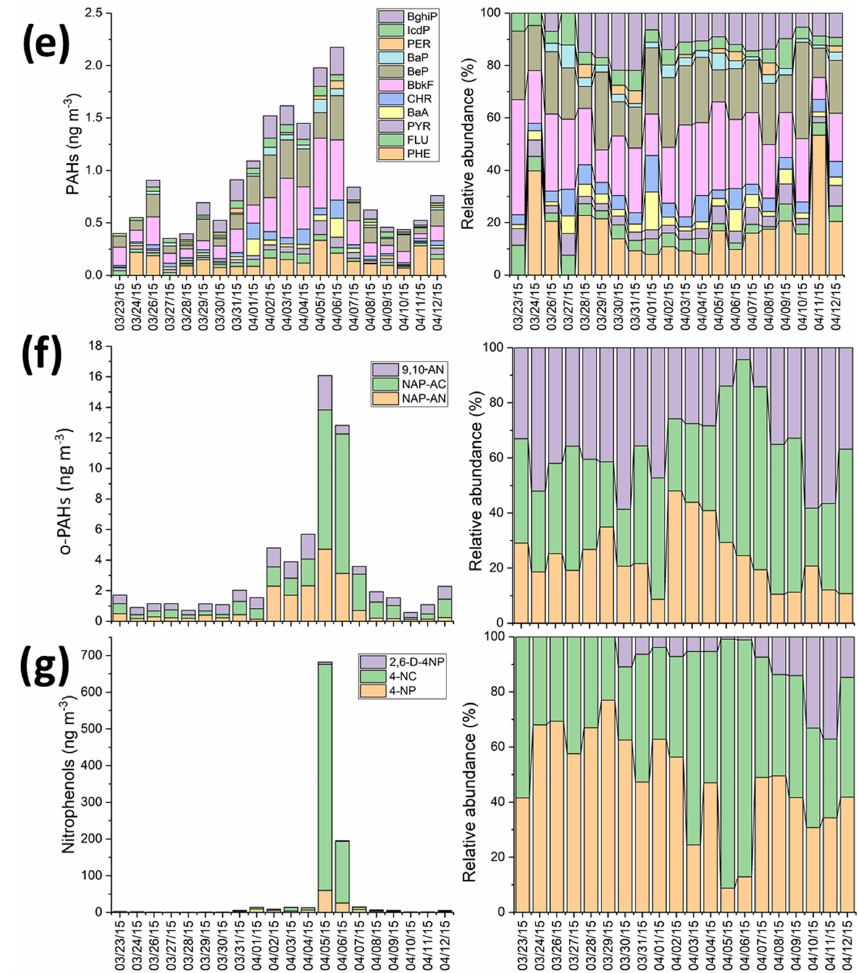
Figure 5. Time series of organic constituents in daily aerosol particle samples ( n = 21) at PDI during the sampling campaign from 23 March to 12 April 2015. (a) Anhydrosugars, (b) methoxyphenols, (c) HMW fatty acids, (d) n -alkanes, (e) PAHs, (f) o -PAHs, (g) nitrophenols. The left column provides mass concentrations (ngm − 3 ) and the right column provides relative mass fractions within the compound